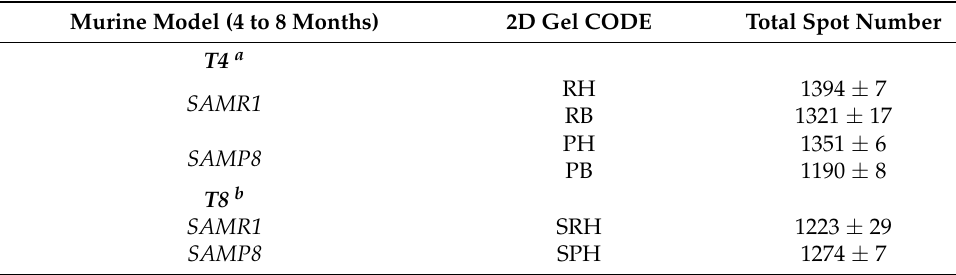
Table 1. Total spot number on 2D maps for T4 and T8